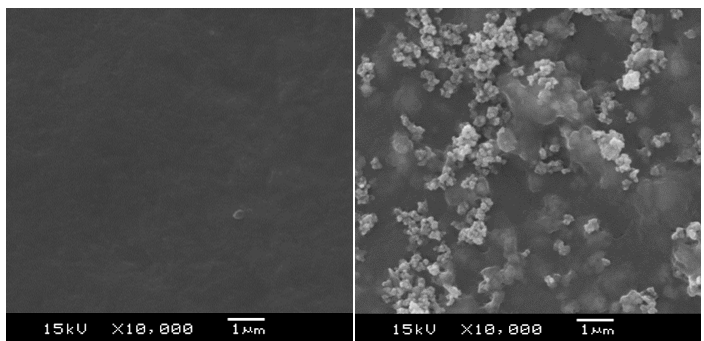
Polymers 2018 , 10 , x FOR PEER REVIEW 9 of 13 Figure 7. Top view SEM images of the surface morphology of two films. On the left, PEDOT:PSS film with an average thickness of 550 nm; on the right, PEDOT:PSS + 2.5% of Fe 2 O 3 film with an average thickness of 814 nm. Both films were deposited using the same wirebar (i.e., bar n°5, wet thickness 50 µm).